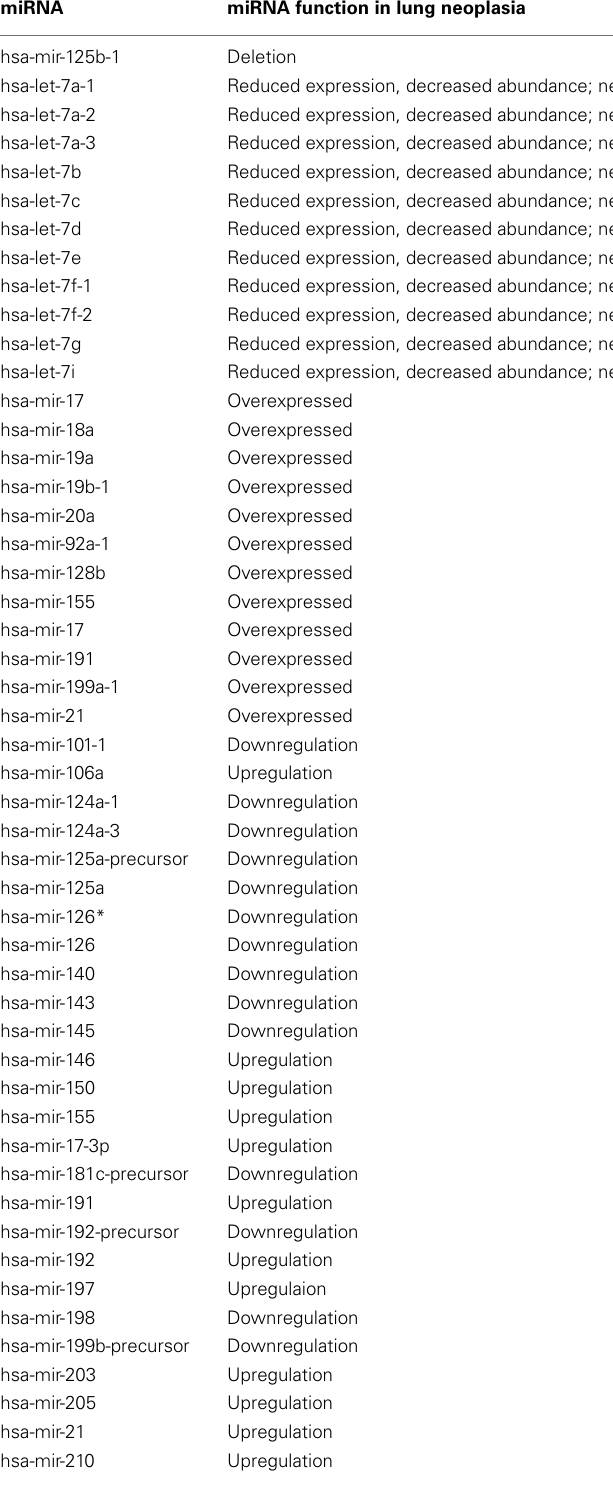
TableA1 | Summary of miRNAs associated with lung